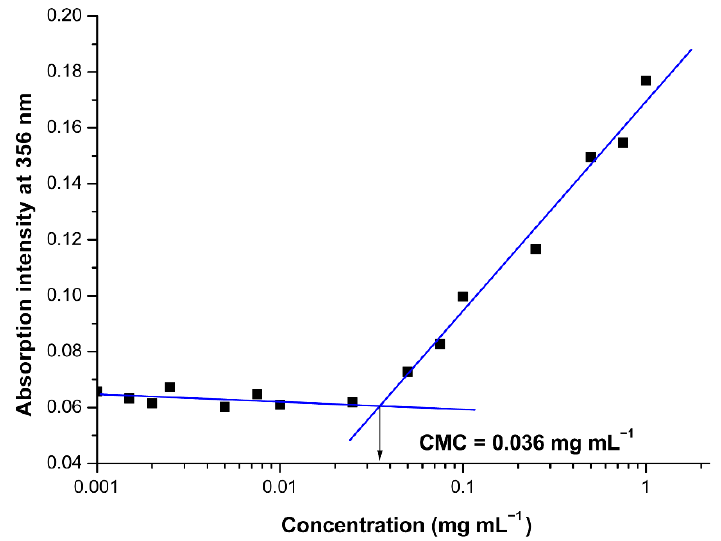
Figure 2. Effect of the oppositely charged block copolymers concentration on the absorption intensity of DPH at 356 nm in aqueous media for PIC micelles formation at 1:1 ionic groups’ molar ratio.